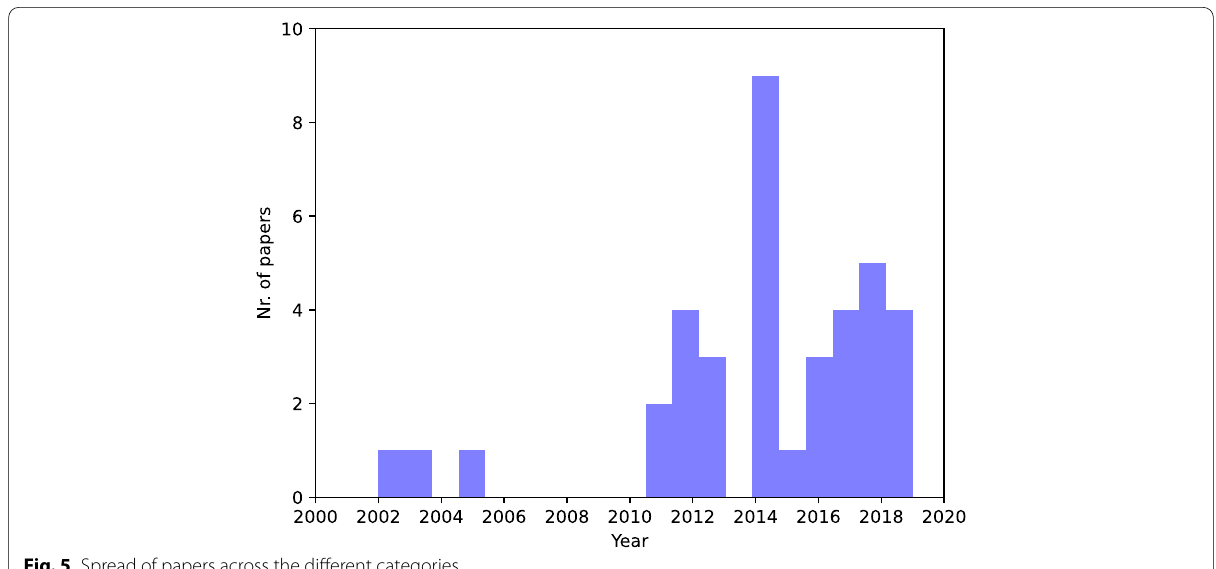
Fig. 5 Spread of papers across the different categories.